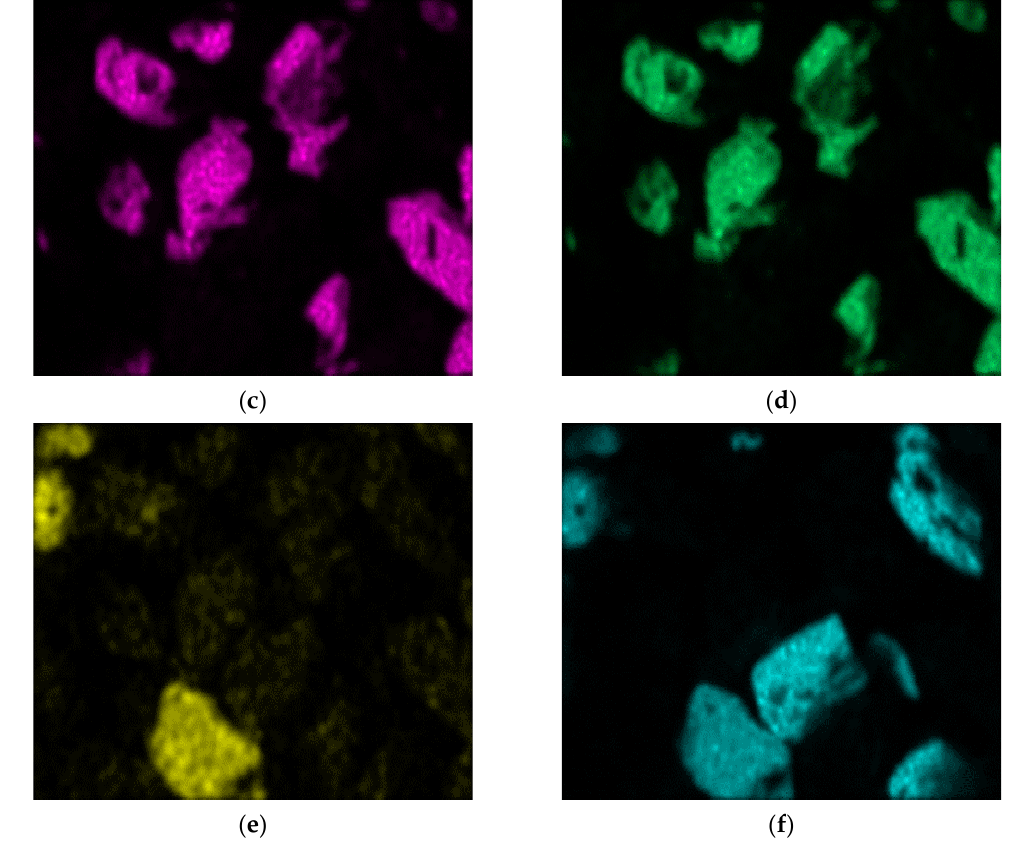
Figure 8. Distribution of the elements: ( a ) fraction 3; ( b ) distribution of the elements on the surface; ( c ) zirconium; ( d ) phosphorus; ( e ) iron; ( f ) titanium.